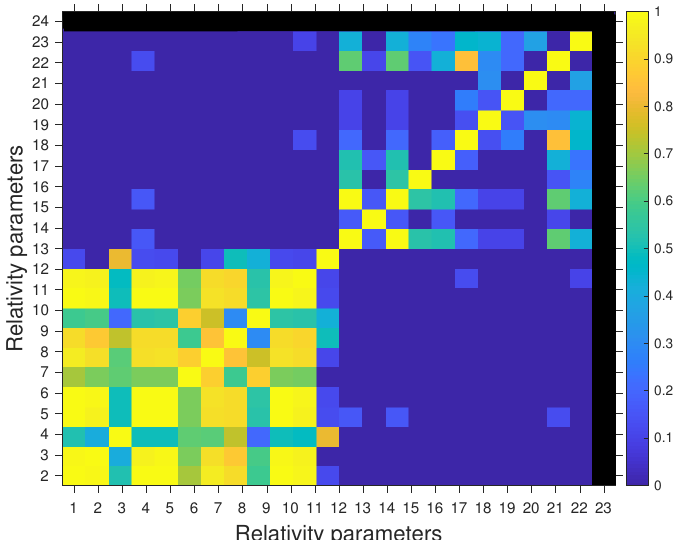
Figure 2. Absolute value of the correlations between the estimated parameters in the case of simulation (a). The parameters are labeled as in Tables 3 and